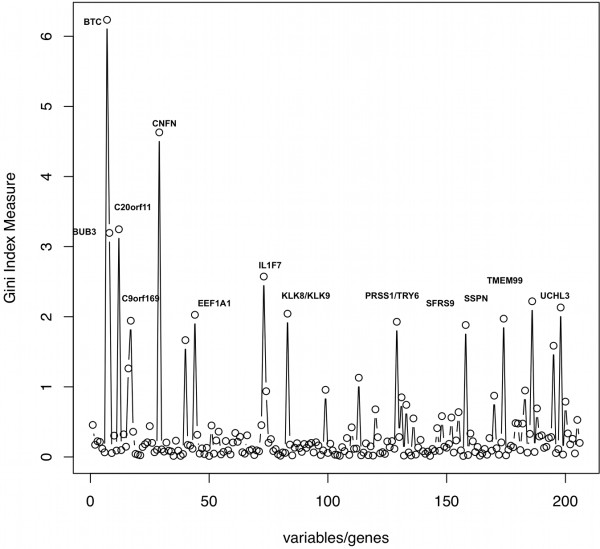
Genes identified as most informative through RF classification of skin tissues in four molecular groups (NN, PN, PP01 and PP02). Gini Index (GI) was used as variable importance measure for estimating the discriminative power of relevant features (genes) and, consequently, their relevance to disease state. The five most important genes in determining disease classes were BTC, CNFN, C20orf11, BUB3 and IL1F7. Genes with related annotation are listed in Table 1.